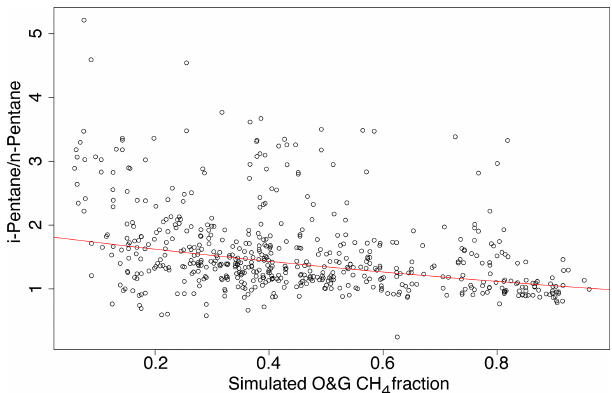
Figure 11. Scatterplot of the fraction of simulated methane due to OG sources against the i -pentane to n -pentane ratio. An exponential model is fitted to the data (red